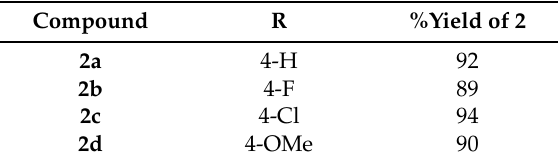
Table 1. percentage yield of compounds 2a–d. Table 1. Percentage yield of compounds